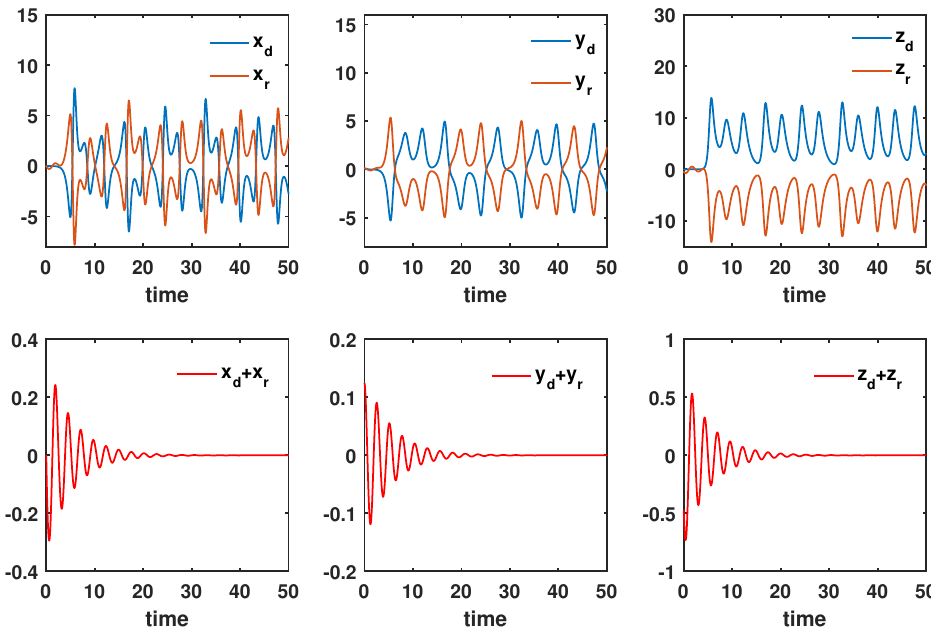
Figure 7. Anti-synchronization of coupled nonidentical 2.85-order Rucklidge